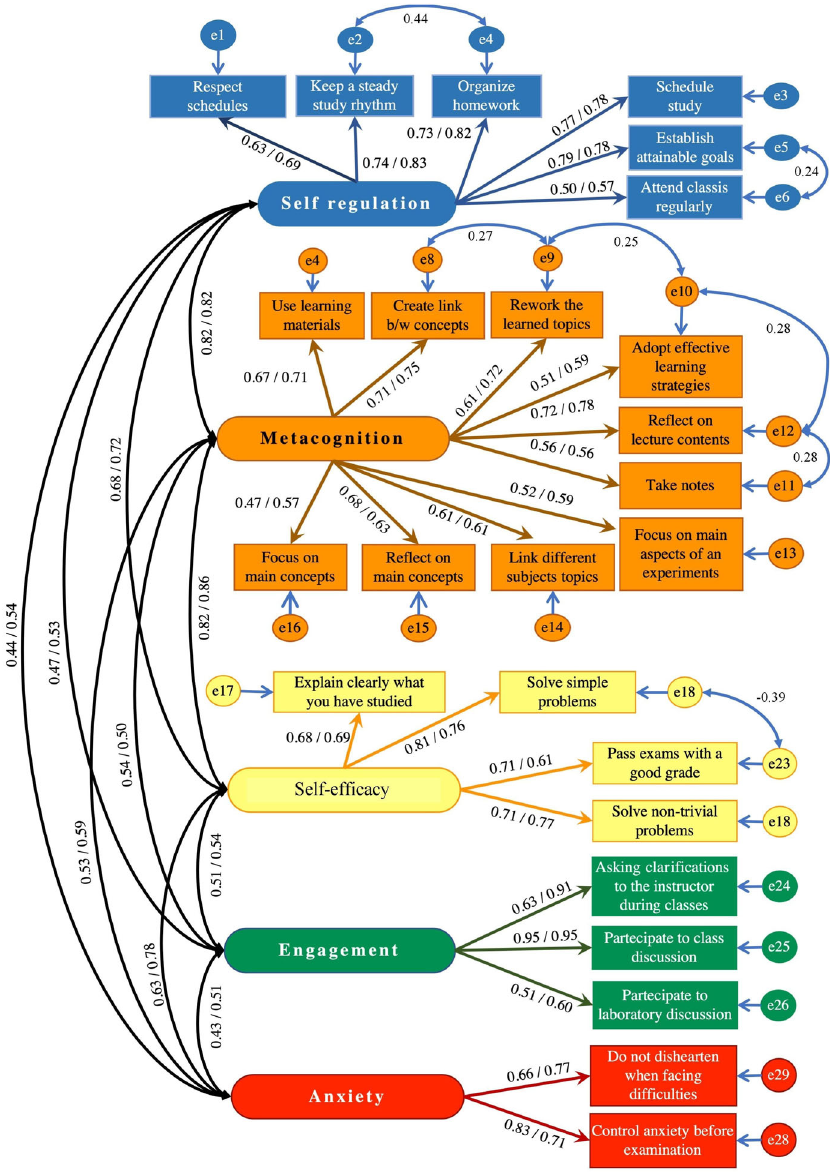
FIG. 5. Factor structure of the physics academic orientation inventory. The unobserved constructs ( factors ) are represented by rounded rectangles. The observed variables (i.e., the questionnaire items) are represented by rectangles. The single-headed arrows represent structural regression coefficients, namely, the factorial loads of an observed variable onto the factor. The measurement errors associated to observed variables are represented by a circle and a small single-headed arrow near the corresponding variable. Two-headed black arrows represent the covariances of the constructs, while two-headed blue arrows represent the error covariances of the items ( modification indices ). The values of the loadings between items and constructs and of the covariances between the constructs are reported in the format before and during emergency remote